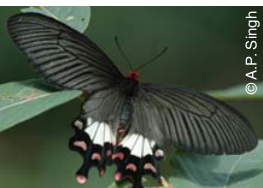
Image 116. Spangle, Papilio protenor